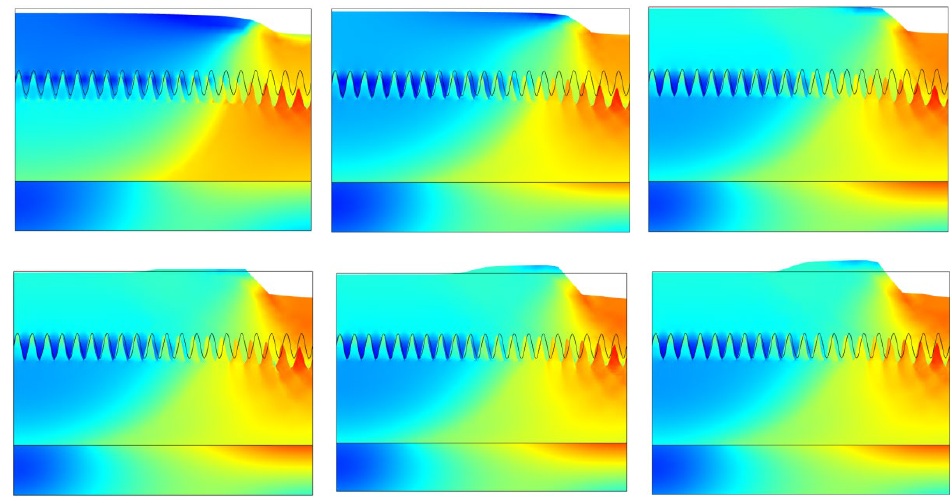
Figure 8. Variation of foundation stress and deformation with upper load.